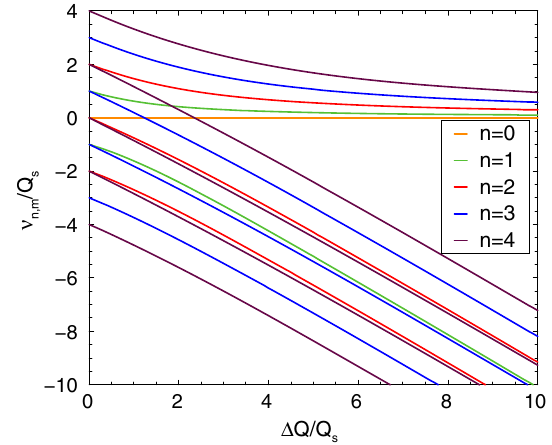
FIG. 1. Eigentunes of the boxcar bunch without a wake. At any n , there are n þ 1 eigentunes starting at Δ Q ¼ 0 from the points ν n;m ¼ mQ s , m ¼ n , n − 2 ; … ; − n